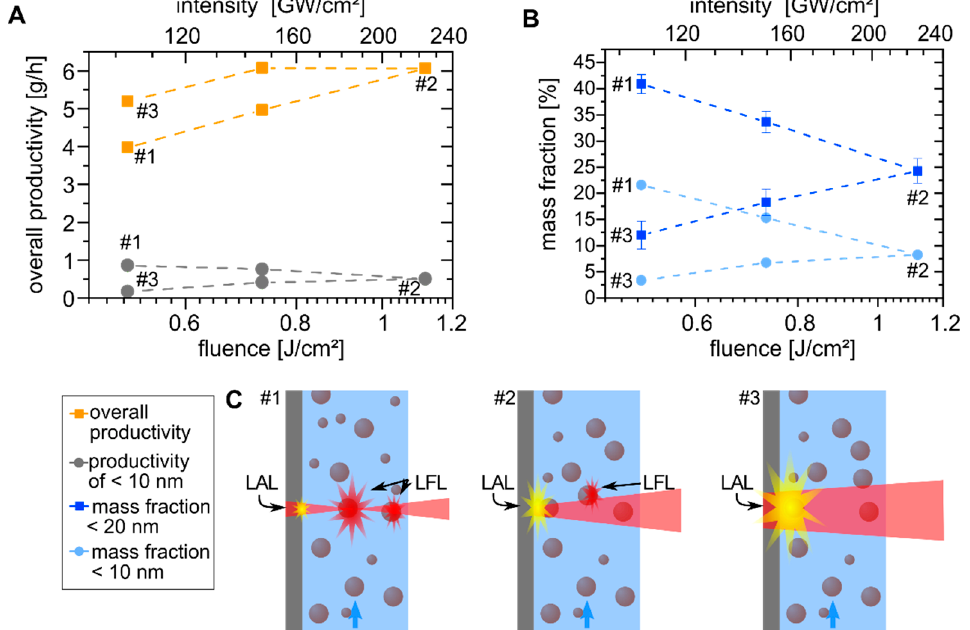
Figure 2. Influence of the applied laser fluence due to the change in the focal plane position on ( A ) the overall productivity (orange squares) and the productivity of the mass fraction of platinum particles smaller than 10 nm (gray circles) and ( B ) the mass fraction of NP < 20 nm (blue squares) and < 10 nm (light blue circles). ( C ) The sketches are related to the three di ff erent focal positions and indicate the change of laser ablation in liquid (LAL) and laser fragmentation in liquid (LFL) during focal plane